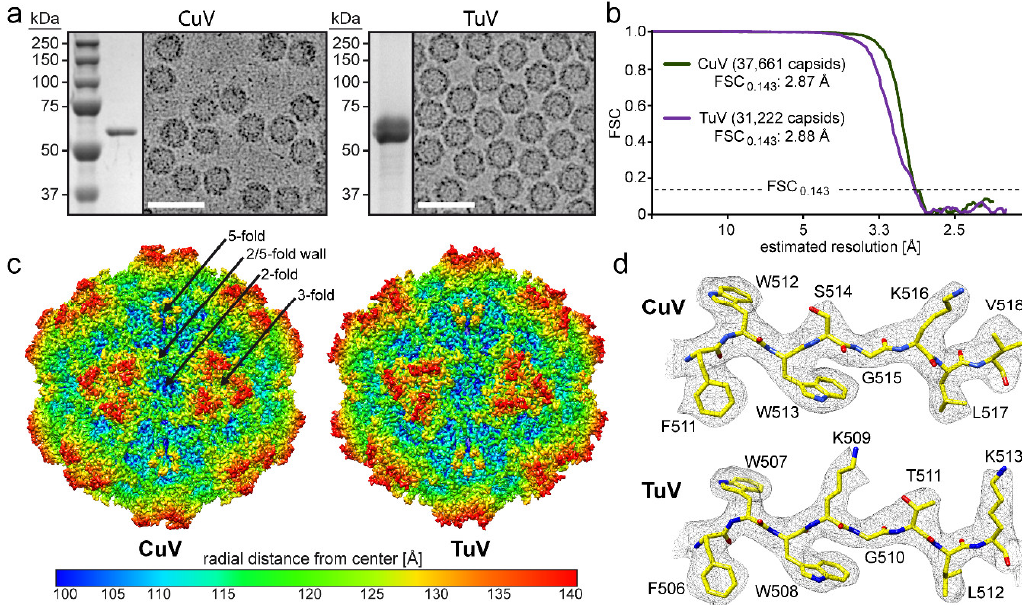
Figure 1. CuV and TuV samples and structures. ( a ) SDS-PAGE of purified CuV and TuV with a band at ~60 kDa equivalent to the size of VP2 and example cryo-electron micrograph. Scale bar: 50 nm. ( b ) Fourier shell correlation (FSC) plotted against resolution for the reconstructed CuV and TuV structures. The resolution of the maps were estimated to be 2.87 and 2.88 Å resolution, respectively, based on an FSC threshold of 0.143. ( c ) The capsid surface density maps contoured at a sigma ( σ ) threshold level of 1.5. The maps are radially colored (blue to red) according to distance to the capsid center, as indicated by the scale bar below. The approximate icosahedral 2-, 3-, and 5-fold axes are indicated on the CuV capsid map. ( d ) CuV and TuV residues modelled for the β I strand are shown inside their density maps (in grey). The amino acid residues are as labeled and shown as stick representation and colored according to atom type: C = yellow, O = red, N = blue. Panel (c) and (d) were generated using UCSF-Chimera [27].